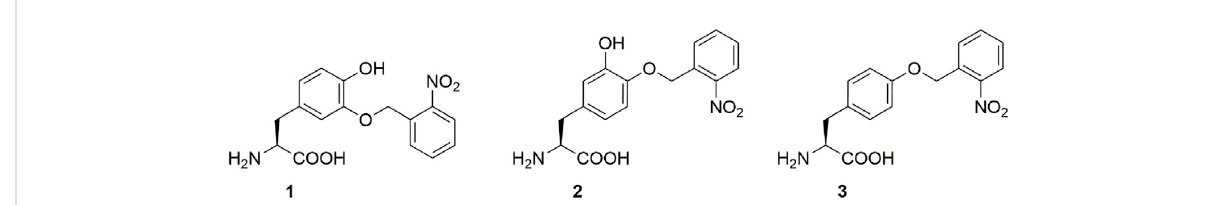
FIGURE 1 Photocaged non-canonical amino acids used in this study. meta -( ortho -(2-nitrobenzyl))-3,4-dihydroxyphenylalanine ( m -oNB-Dopa, 1 ), para - ( ortho -(2-nitrobenzyl))-3,4-dihydroxyphenylalanine ( p -oNB-Dopa, 2 ) and ortho -nitro-benzyl-tyrosine (ONBY, 3